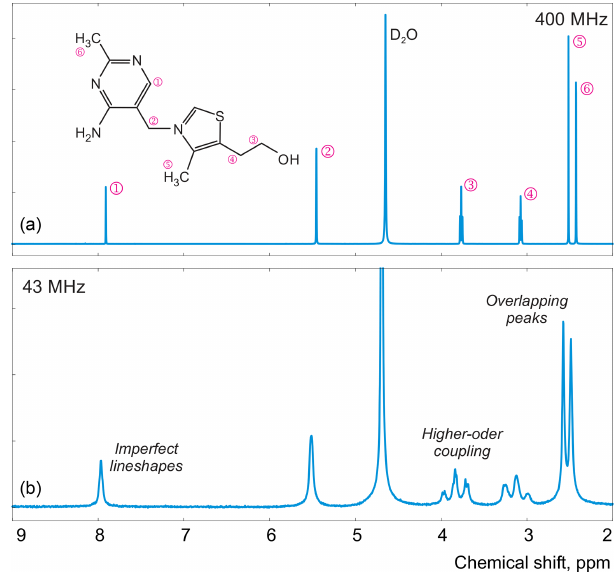
Figure 1. Examples of spectra of thiamine acquired with high- field (a) and medium-field (b)